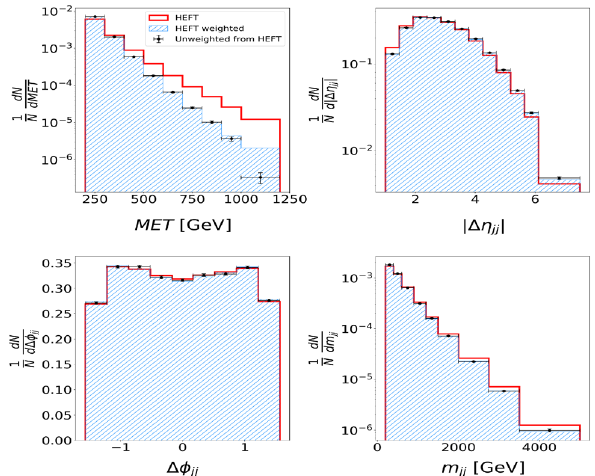
Fig. 16 Comparative distribution of kinematic variables for HEFT, weighted with finite-top mass effects and unweighted distributions for passed events used in deep-learning training and